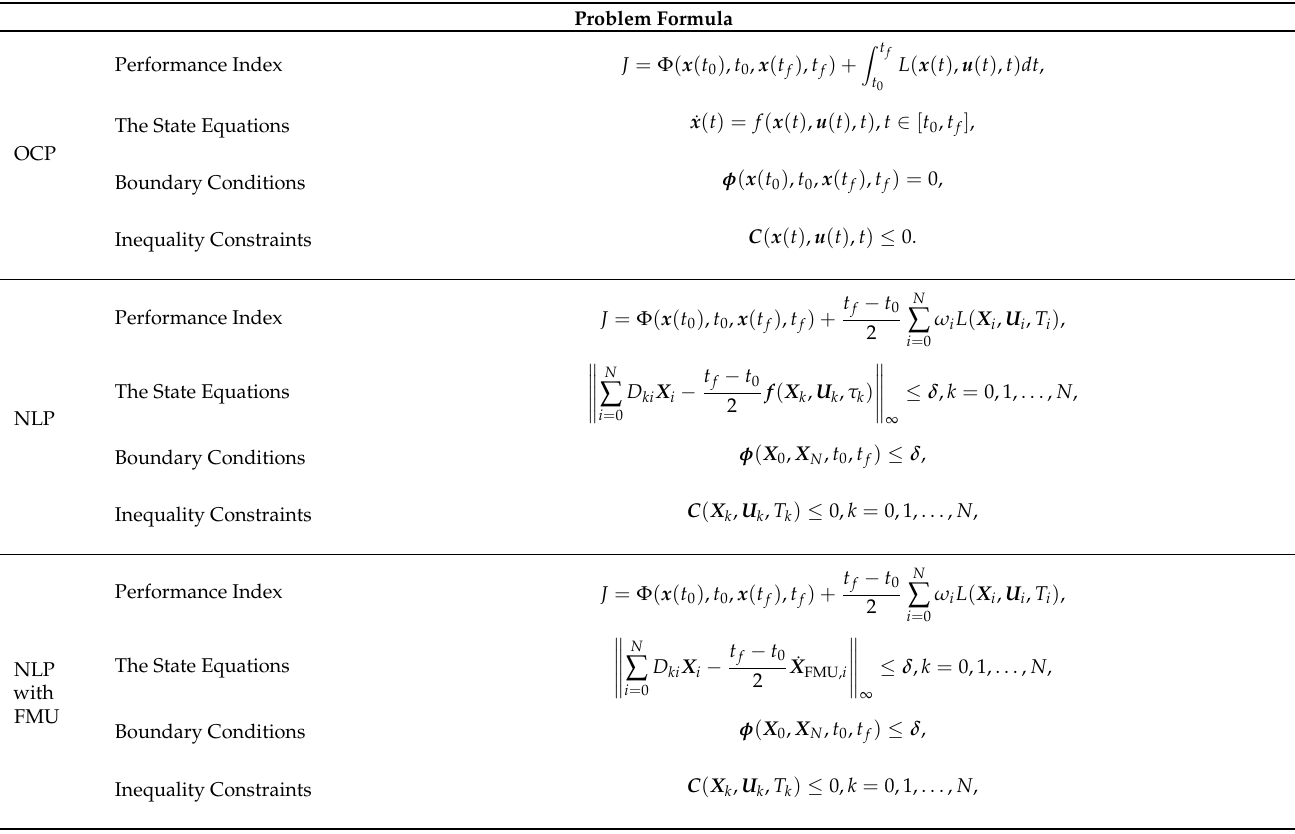
Table A1. Problem Formulas